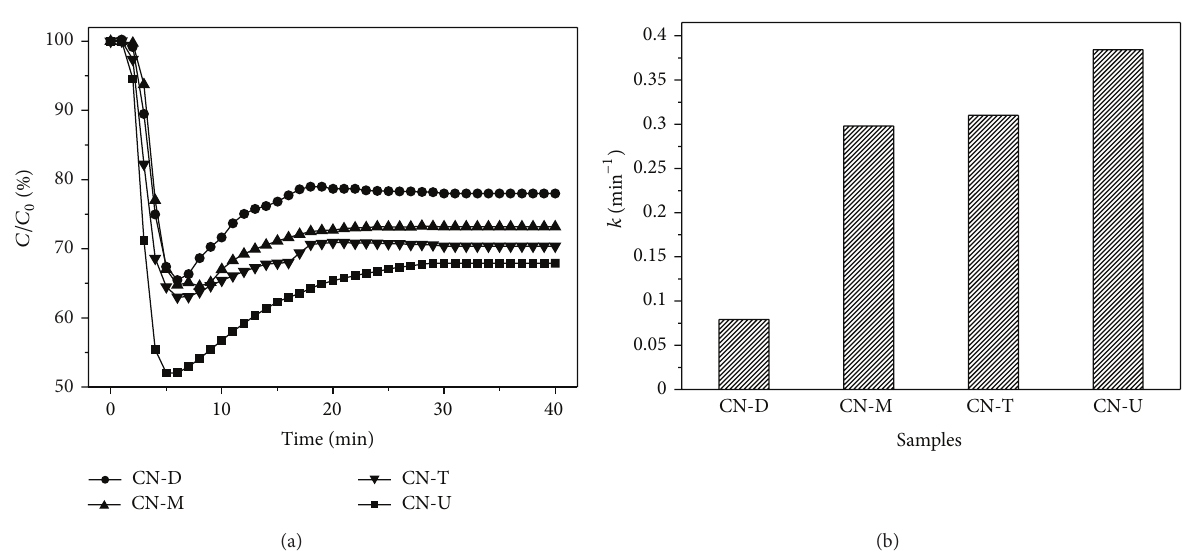
Figure 7: Photocatalytic activity (a) and initial rate constants (b) of CN-T, CN-D, CN-M, and CN-U for removal of NO under visible light irradiation ( 𝜆 > 420 nm) at room